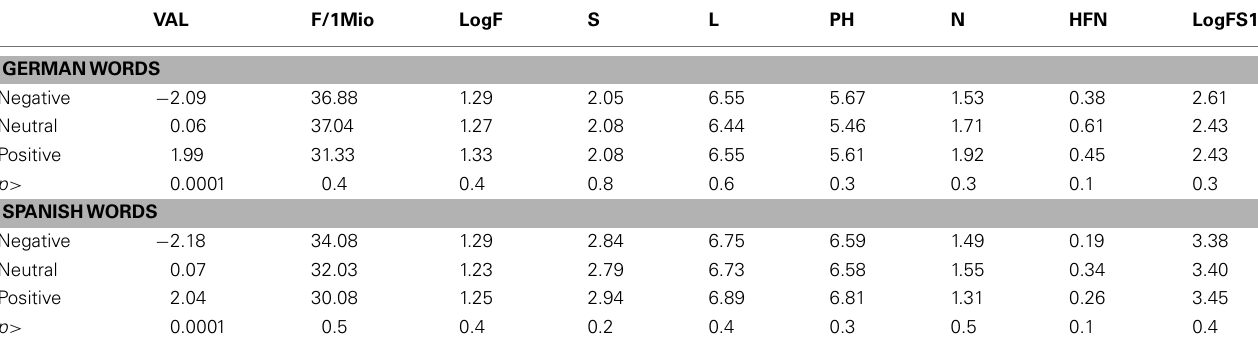
Table 2 | Means for independent variables (valence) and control variables, i.e., word length (syllables, S; letters, L; and phonemes, PH) word frequency (per 1 million of occurrences: F/1Mio and log (10) per 1 million of occurrences: LogF), orthographic neighborhood density (N) and frequency (number of higher frequency orth. neighbors: HFN) and initial syllable frequency [log (10) per 1 million of occurrences: LogFS1] for German and Spanish word